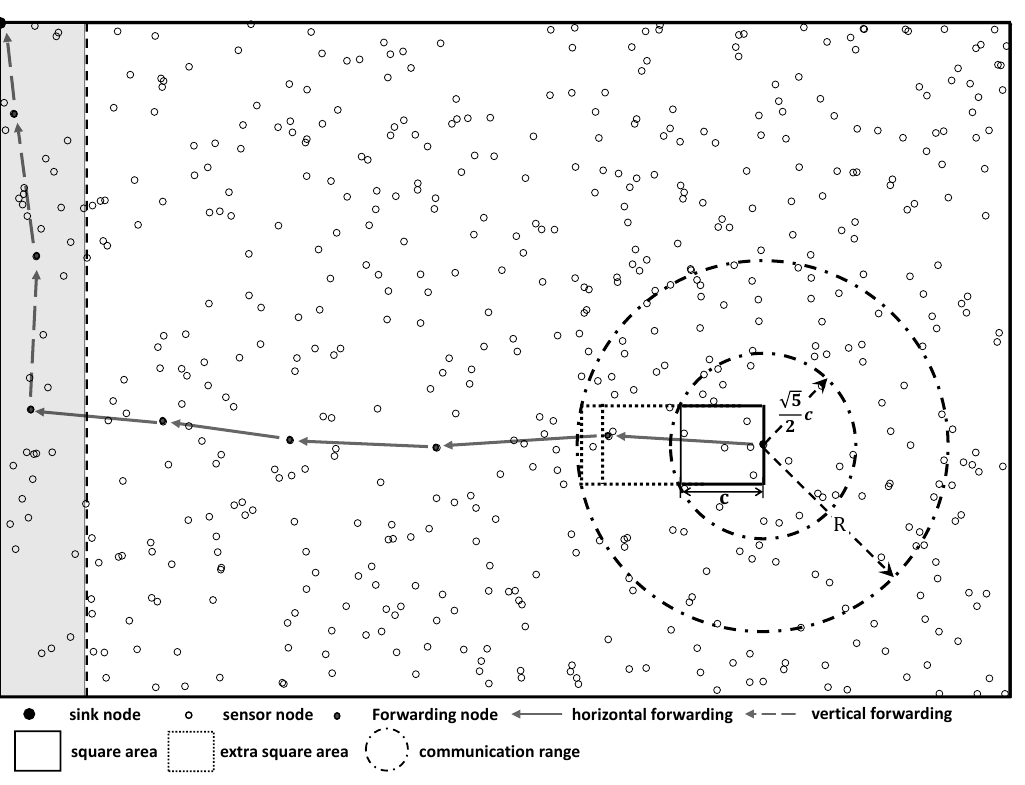
Figure 1. Directional data forwarding topology for a high density distributed wireless sensor